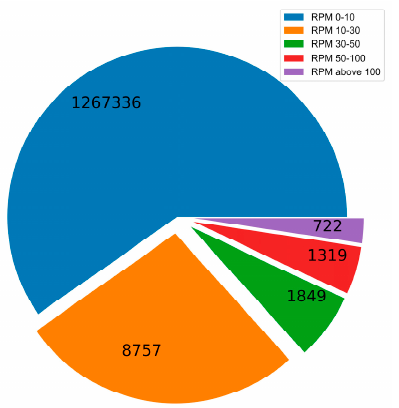
Figure 4. The sequence reads of each RPM value distribution of sRNA.